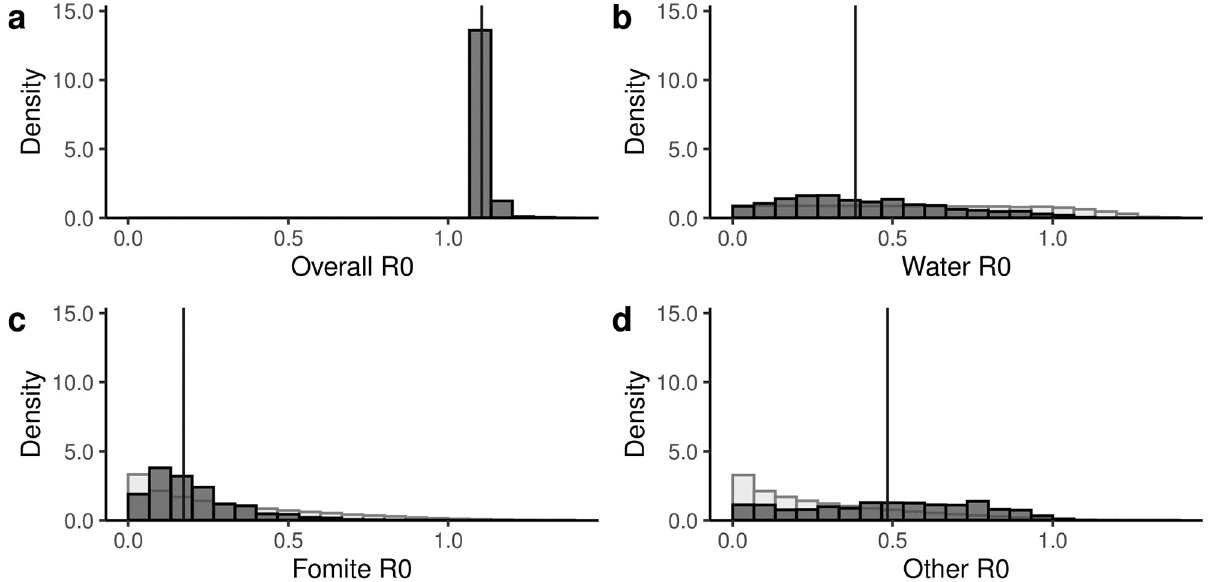
Fig 6. Reproduction numbers. Posterior distributions (dark grey) of the (a) overall basic reproduction number R reproduction number, (c) the fomite pathway reproduction number, and (d) the other pathway reproduction number. Prior distributions (light grey) are given for the three sampled parameters; prior distributions are not uniform because they are products of underlying uniformly distributed parameters. Vertical lines give median